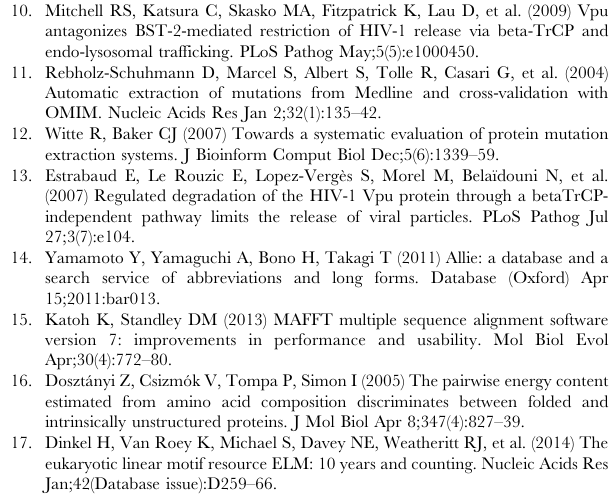
Table S2 The nomenclature for HIV isolates. The dictionary of HIV strains/isolates and their corresponding synonyms, used to identify the HIV isolates mentioned in the publications.